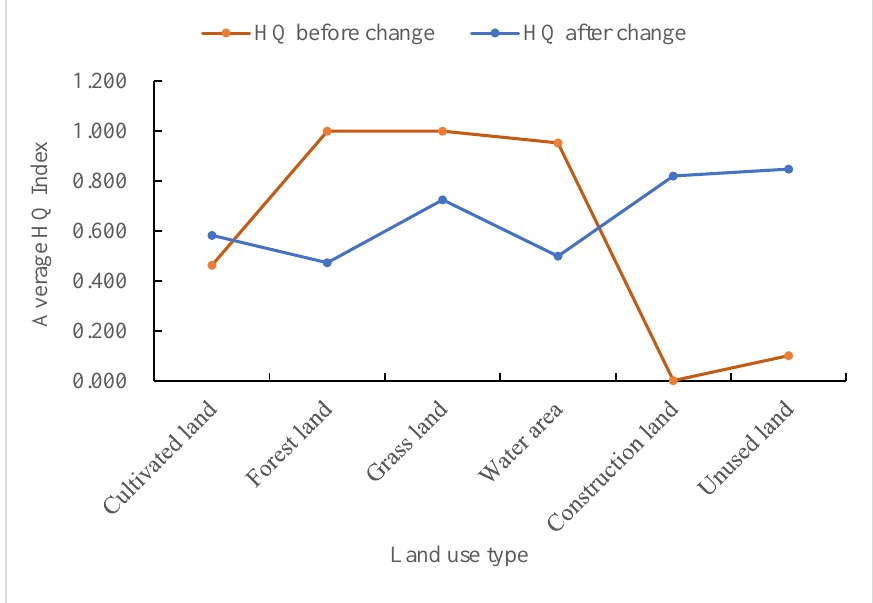
Figure 9. HQ index values before and after land use type change from 2000 to 2020.